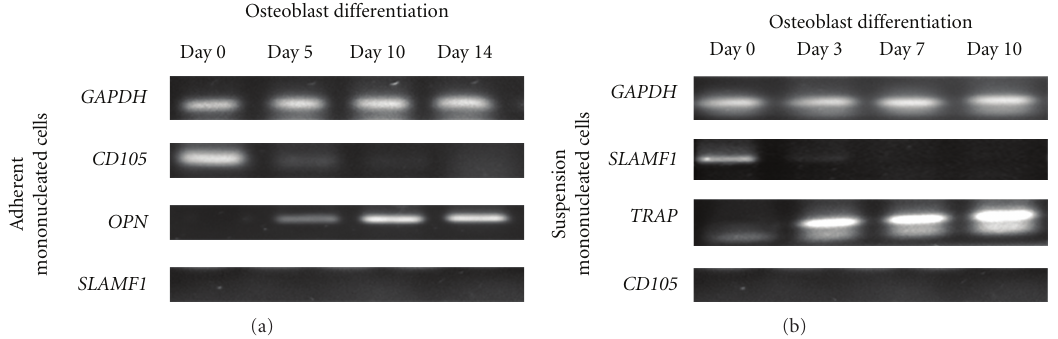
Figure 3: Gene expression profiles during osteoblast and osteoclast di ff erentiation from human mononucleated cells. Adherent and suspension mononucleated cells were induced to di ff erentiate into osteoblast (a) and osteoclast (b) cells, respectively. The expression profiles of OPN (234bp) and TRAP (176bp) were used as osteoblast and osteoclast markers, respectively. The expression profile of GAPDH was used as a